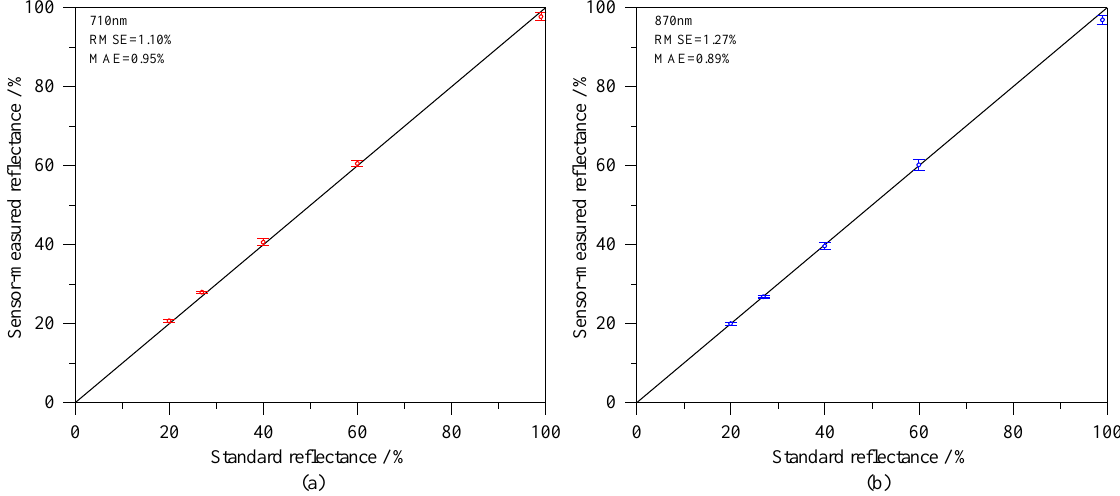
Figure 12. Sensor-measured reflectance vs. standard reflectance. ( a ) 710 nm; ( b ) 870 nm.